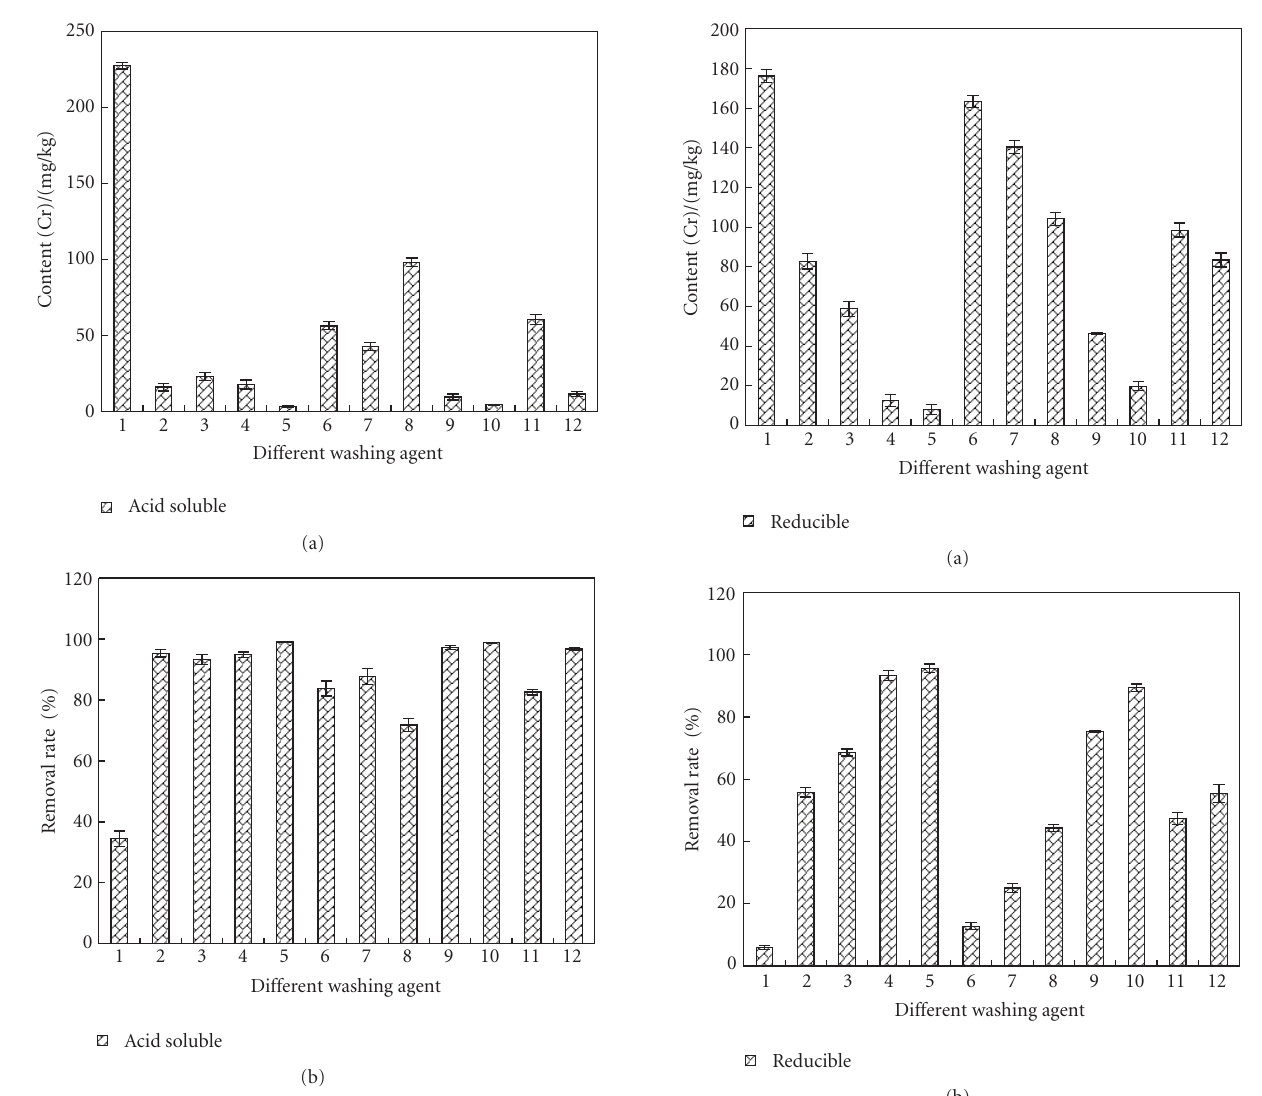
Figure 9: Removal e ff ect of reducible Cr by di ff erent washing agents. Washing agent: 1—water; 2—0.05 mol/L EDTA-Na 2 ; 3— 0.1mol/L EDTA-Na 2 ; 4—0.1 mol/L citric acid; 5—0.5 mol/L citric acid; 6—0.1 mol/L oxalic acid; 7—0.5 mol/L oxalic acid; 8— 0.1mol/L HCl; 9—0.5 mol/L HCl; 10—1mol/L HCl; 11—0.1 mol/L acetic acid; 12—0.5 mol/L acetic